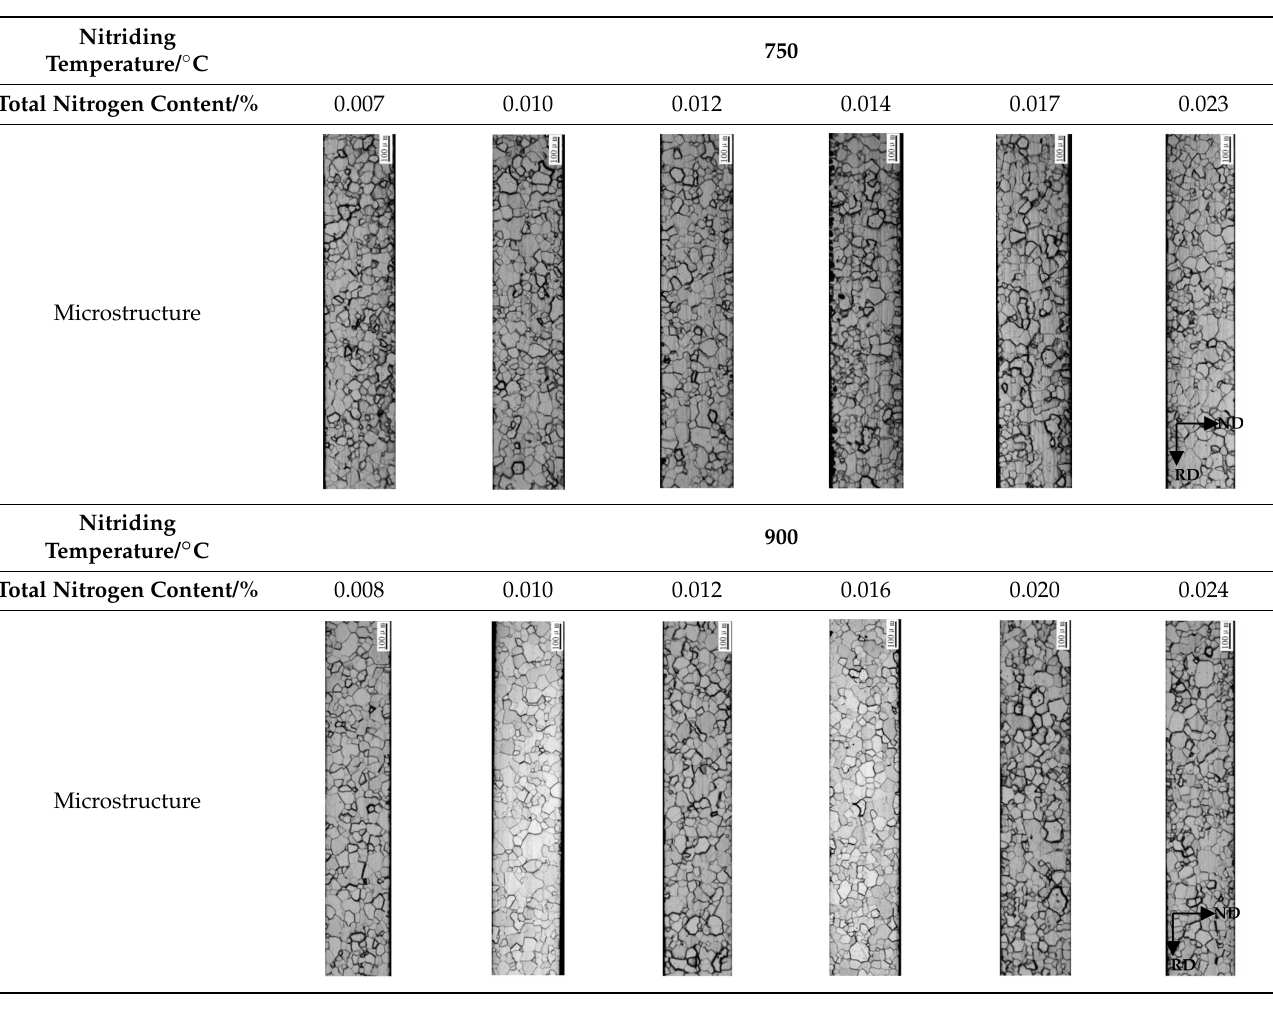
Table 1. Typical primary recrystallization microstructures of decarburized sheets after nitriding annealing at 750 ◦ C and 900 ◦